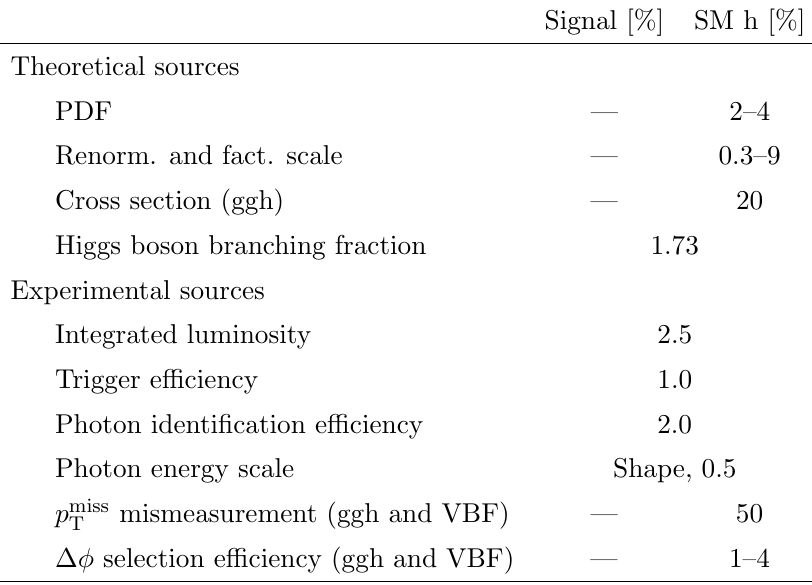
Table 3 . Systematic uncertainties a(cid:11)ecting the signal and resonant backgrounds in the h ! (cid:13)(cid:13)